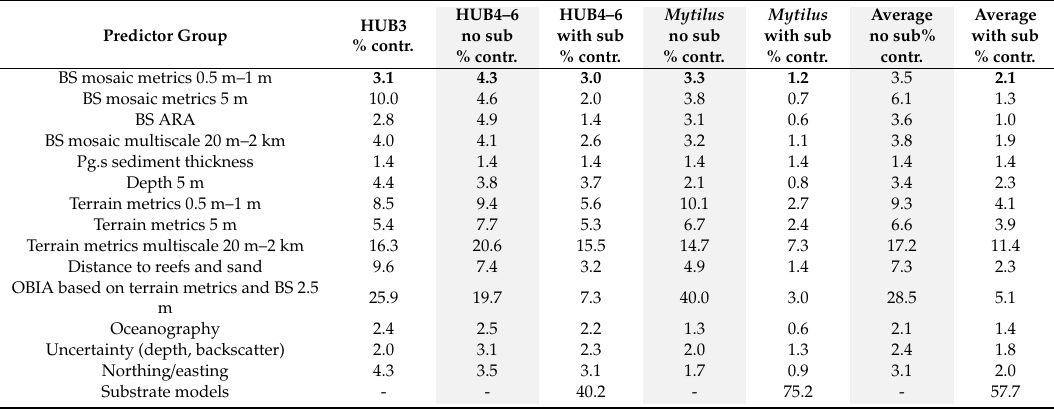
Table A1. Percent contribution of predictors (grouped by theme, see Supplementary Materials, Table